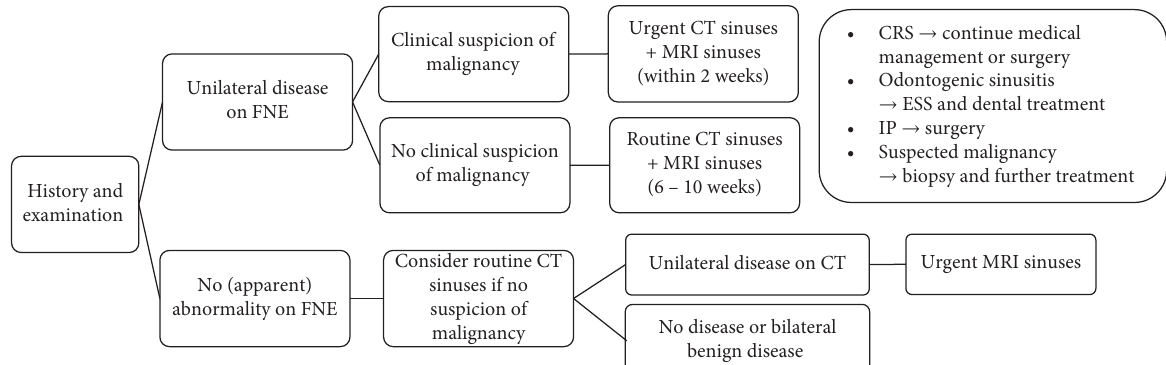
Figure 4: Example diagnostic pathway for unilateral maxillary sinus opacification. Flexible nasal endoscopy (FNE), chronic rhinosinusitis (CRS), endoscopic sinus surgery (ESS), and inverted papilloma (IP).